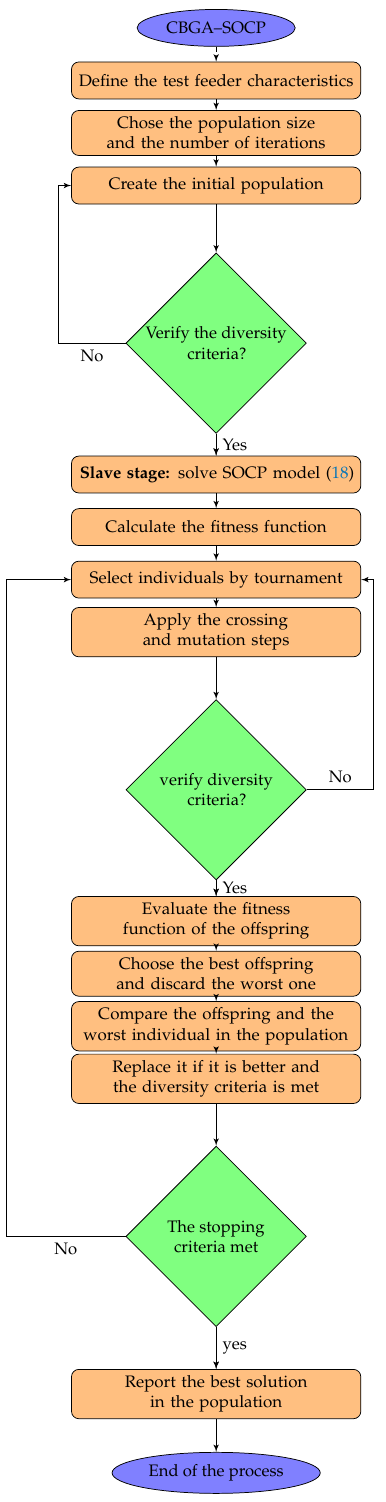
Figure 2. Flowchart of the Chu and Beasley genetic algorithm (CBGA)-second-order cone pro- gramming (SOCP) approach for the optimal sizing and placement of D-STATCOMs in electrical distribution grids.